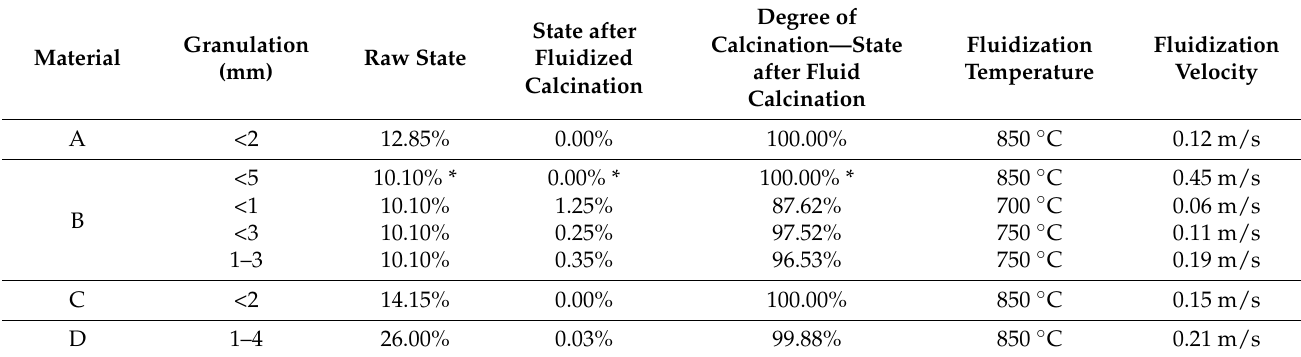
Table 5. Loss on ignition and degree of calcination of the examined clay materials.